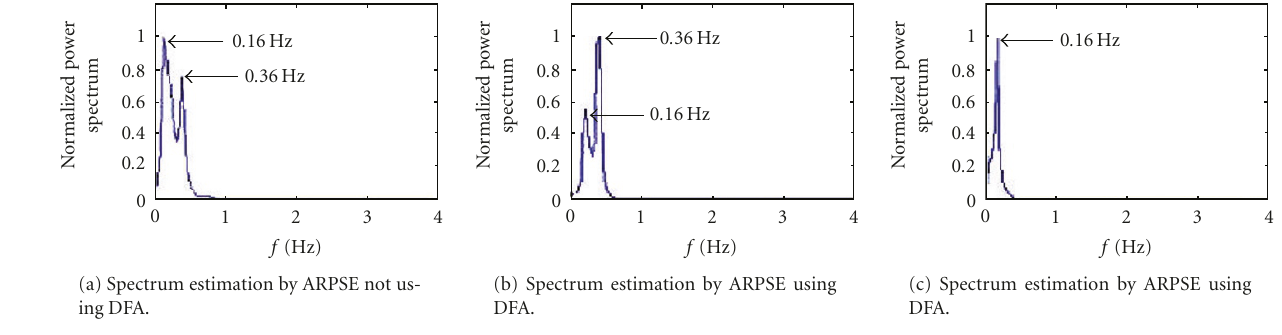
Figure 4: The signals processed by DFA.